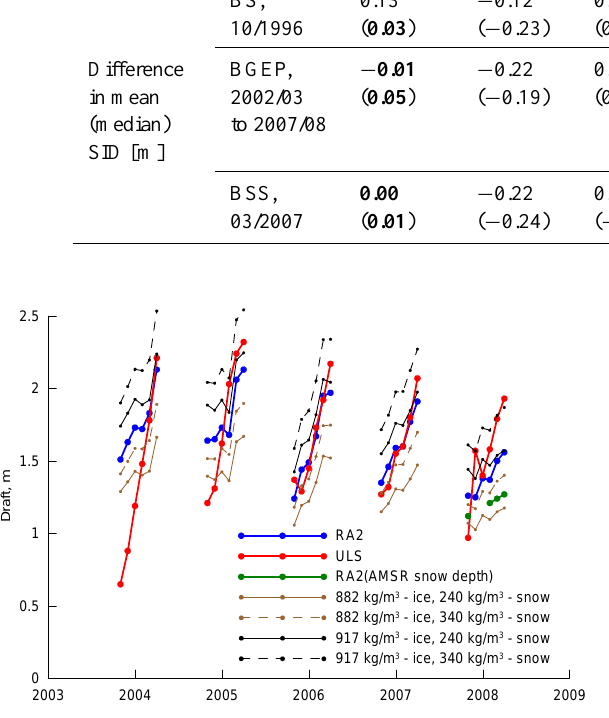
Figure 7. BGEP ULS draft data, averaged to monthly mean for the winter months October to March (red) compared to monthly mean draft computed from RA-2 sea ice freeboard using W99 snow depth and density and standard values: ρ i = 900kgm − 3 and ρ w = 1030kgm − 3 (blue); W99 snow depth but MYI den- sity: ρ i = 882kgm − 3 (brown); W99 snow depth and FYI den- sity: ρ i = 917kgm − 3 (black); and AMSR-E snow depth (green). Note that the latter is only possible for FYI areas. Snow density is set fixed to either 240kgm − 3 (solid lines) or 340kgm − 3 (broken lines) for the lines where sea ice density is varied (brown +